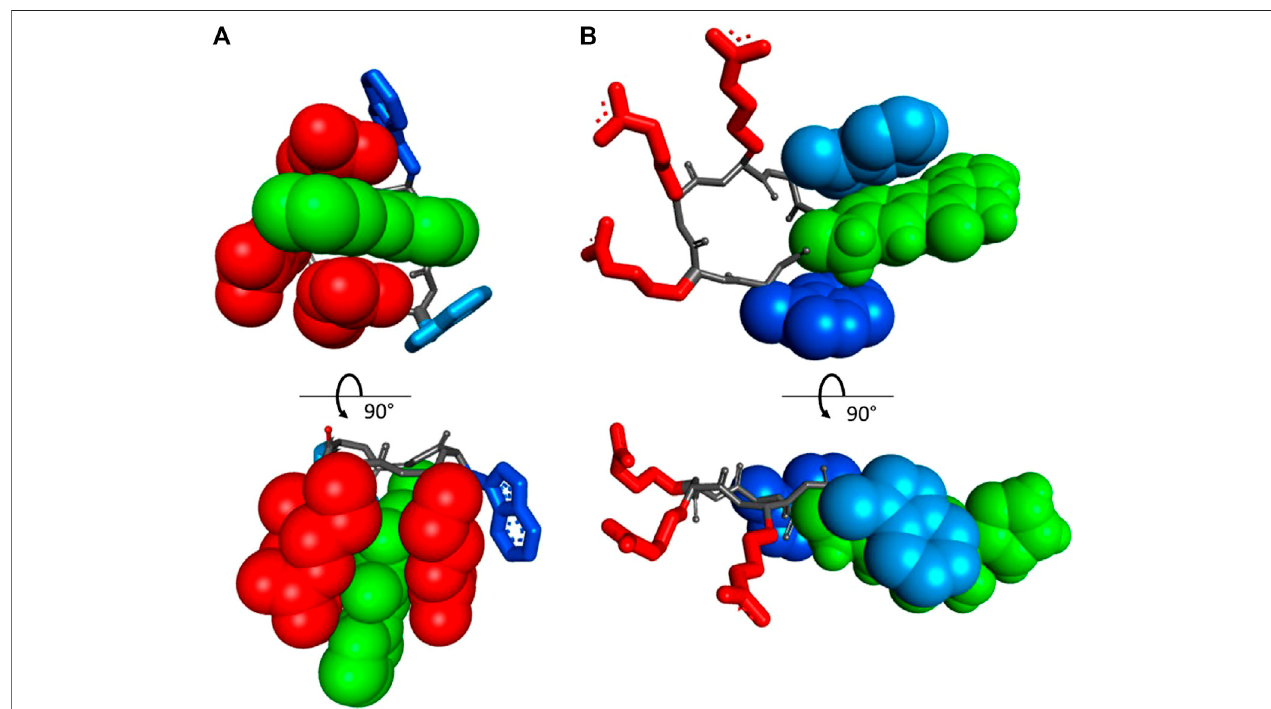
FIGURE 6 | Orthogonal projections of the two energetically preferred conformations in vacuo of the peptide cRW-F 2 /FHC, according to an MM+ molecular modelingrun: (A) “ closed ” state,whereallthreearginylsinteractwiththeFHCside-chain,and (B) “ open ” state,wherethearginylclusterandthearomaticside-chainsare well separated. The FHC residue is in green and CPK. Trp 1 and Trp 3 are in dark and light blue, respectively. The residues interacting with FHC are shown in CPK rendering mode.